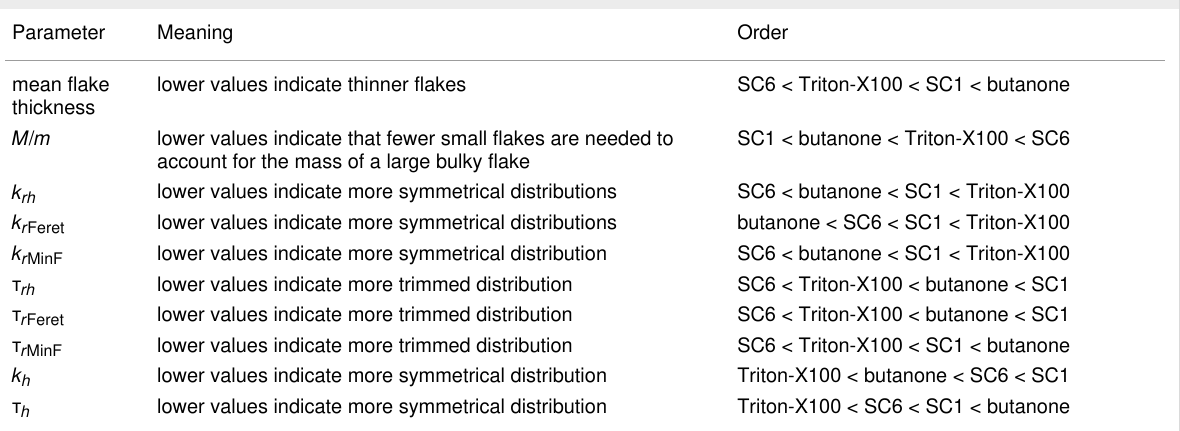
Table 2: h SC6 < h Triton-X100 < h SC1 < h butanone .